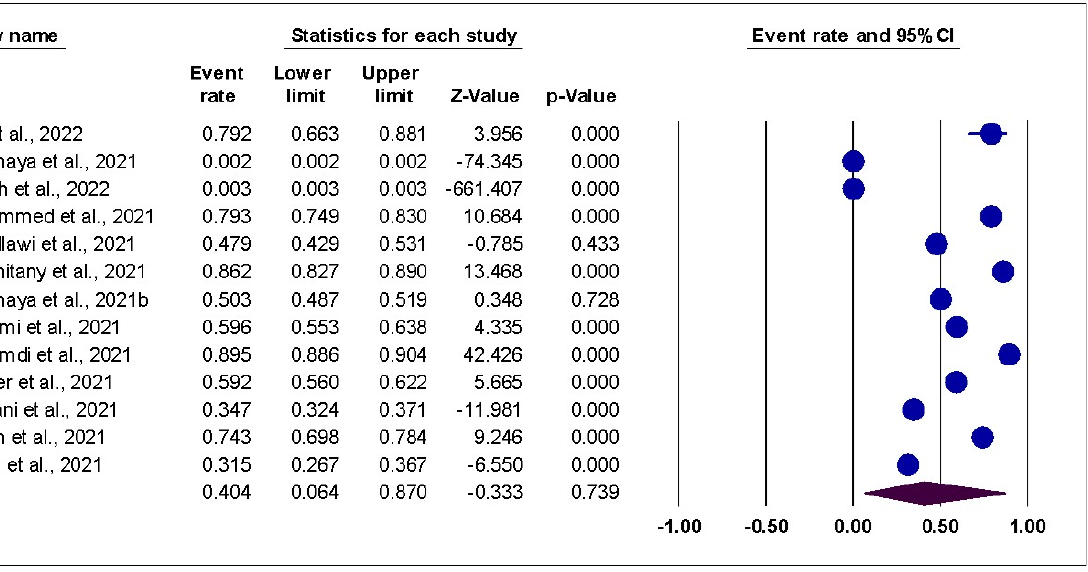
Figure 2. Forest Plot of overall AEs; shows the pooled analysis of overall AEs among vaccinated individuals.